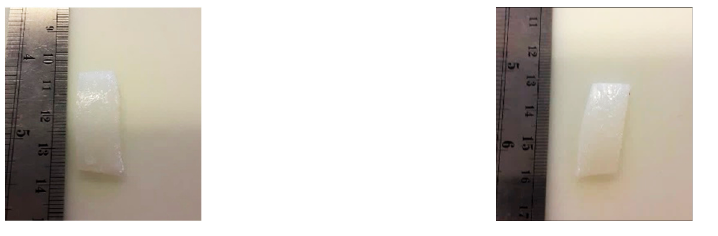
Figure 3. Nodule pieces after 7 days (left) and 28 days (right) in contact with the SA–PA mixture at 85 °C.